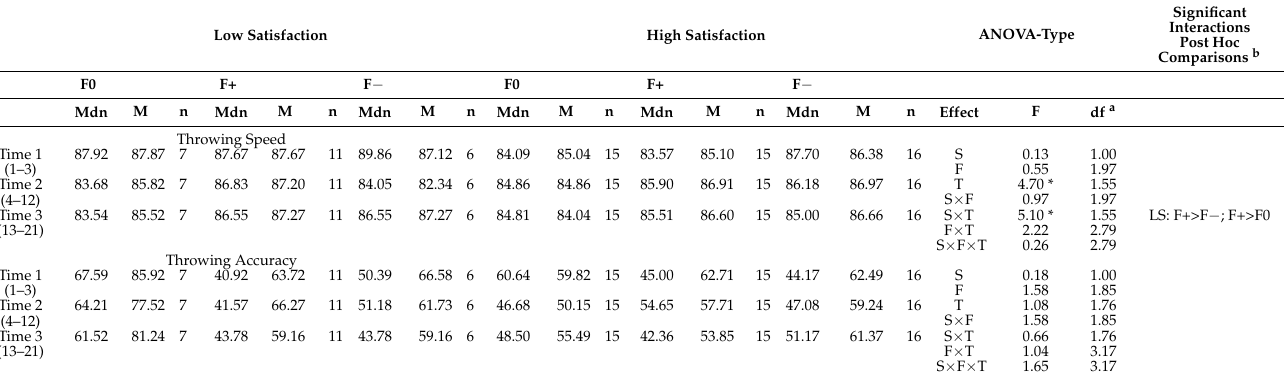
Table 2. Descriptives and nonparametric repeated measures ANOVA-type models of performance variables for each type of feedback, satisfaction with the coach, time of measure, and their